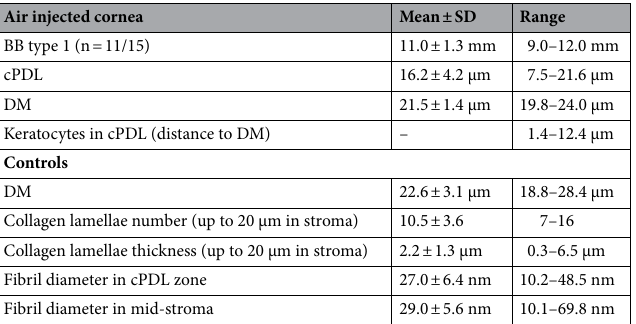
Table 1. Morphometric data of the canine pre-Descemet’s layer and the Descemet’s membrane. SD standard deviation, BB big bubble, cPDL canine pre-Descemet’s layer, DM Descemet’s membrane.